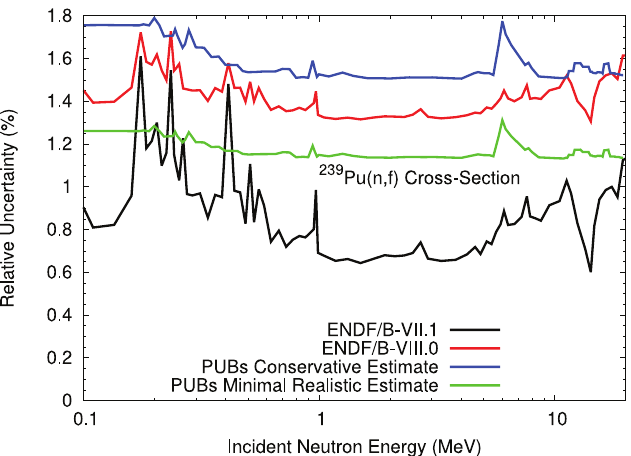
Fig. 5. The conservative and minimal realistic total PUBs bounds are compared to ENDF/B-VII.1 (previous NDS) and ENDF/B-VIII.0 (current NDS) 239 Pu(n,f) cross-section uncer-